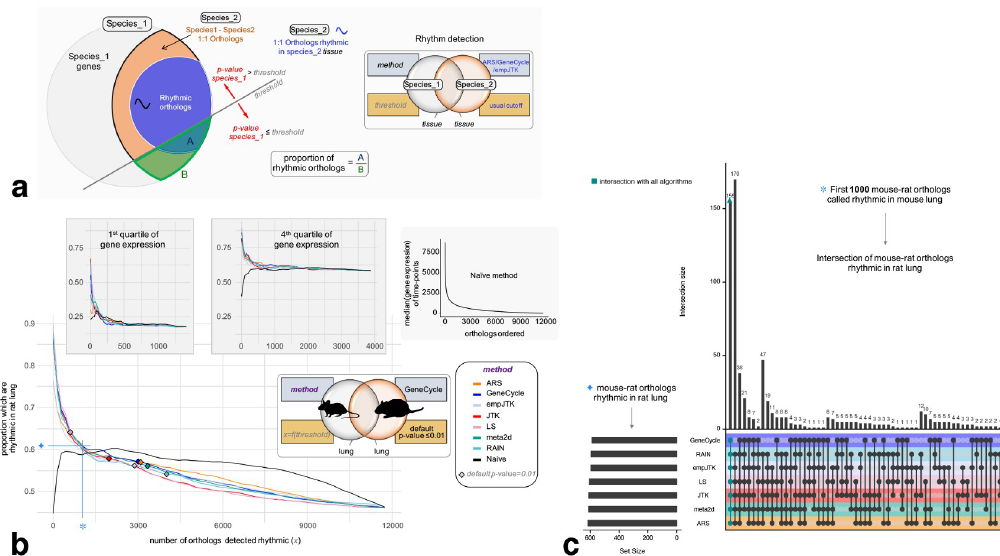
Fig 6. Only strong rhythmic signals of gene expression are relevant. Methods designed for rhythm detection in gene expression show an advantage only for the genes with a strong rhythmic signal, i.e. related to very small p -values. For a fixed number of top genes called rhythmic, all the methods, despite their design differences, retrieve approximately the same proportion of biologically functional rhythmic genes and the same genes themselves. a) Method to obtain figure b: For a given p - value threshold, each method detects a certain number of rhythmic genes (genes with p -value � threshold). At each threshold, we calculate the proportion of orthologs rhythmic in species2 (A) among one-to-one species1-species2 orthologs (B). The benchmark set is composed of one-to-one orthologs detected rhythmic in the second species (using method ARS, GeneCycle, or empJTK), called rhythmic orthologs. b) Variation of the proportion rhythmic orthologs/all orthologs in mouse as a function of the number of mouse orthologs detected rhythmic, for each method applied to the mouse lung dataset. The benchmark gene set is composed of mouse-rat orthologs, detected rhythmic in rat lung by the GeneCycle method with default p -value � 0.01. The black line is the Naive method which orders genes according to their median expression levels (median of time-points), from highest expressed to lowest expressed gene, then, for each gene, calculates the proportion of rhythmic orthologs among those with higher expression. The proportion of the benchmark set among one-to-one orthologs is higher for highly expressed genes (4th quartile) than for lowly expressed genes (1st quartile) ( * 60% vs * 20% respectively). Diamonds correspond to a p -value threshold of 0.01. c) Upset diagram showing the number of rhythmic orthologs (figure a ) called in common by the methods among the first 1000 mouse-rat orthologs that are called rhythmic in mouse lung. Images credit: Anthony Caravaggi (mouse) and Public Domain for other images (from